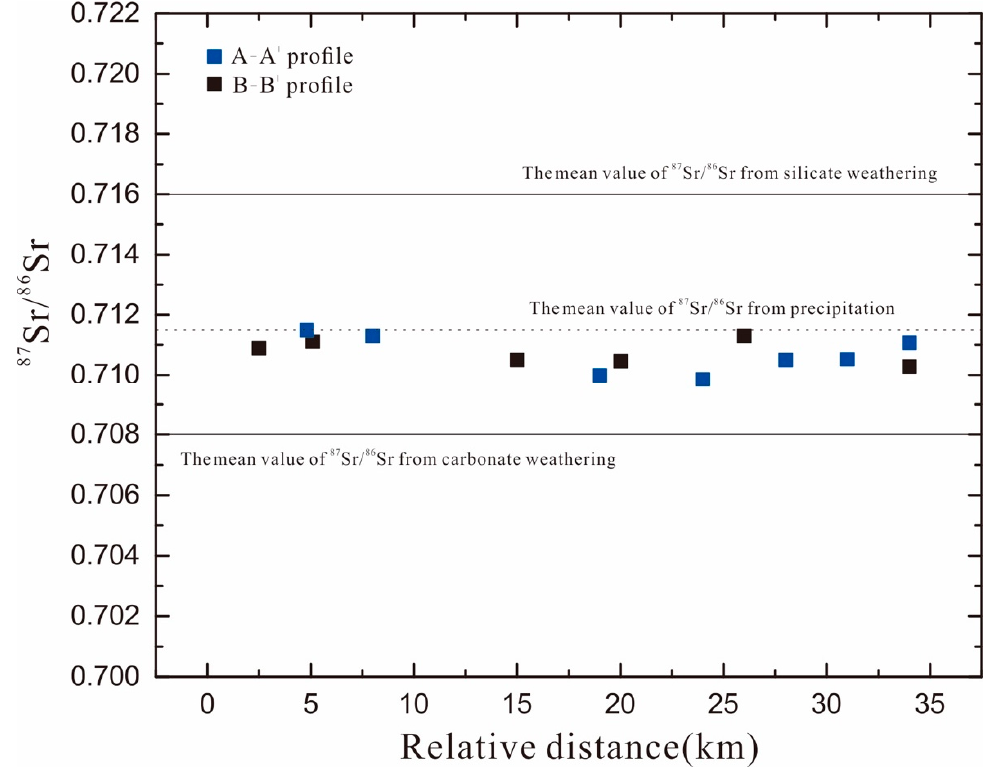
Figure 9. 87 Sr/ 86 Sr ratio from different sources—lake water and groundwater. Figure 9. 87 Sr / 86 Sr ratio from di ff erent sources—lake water and